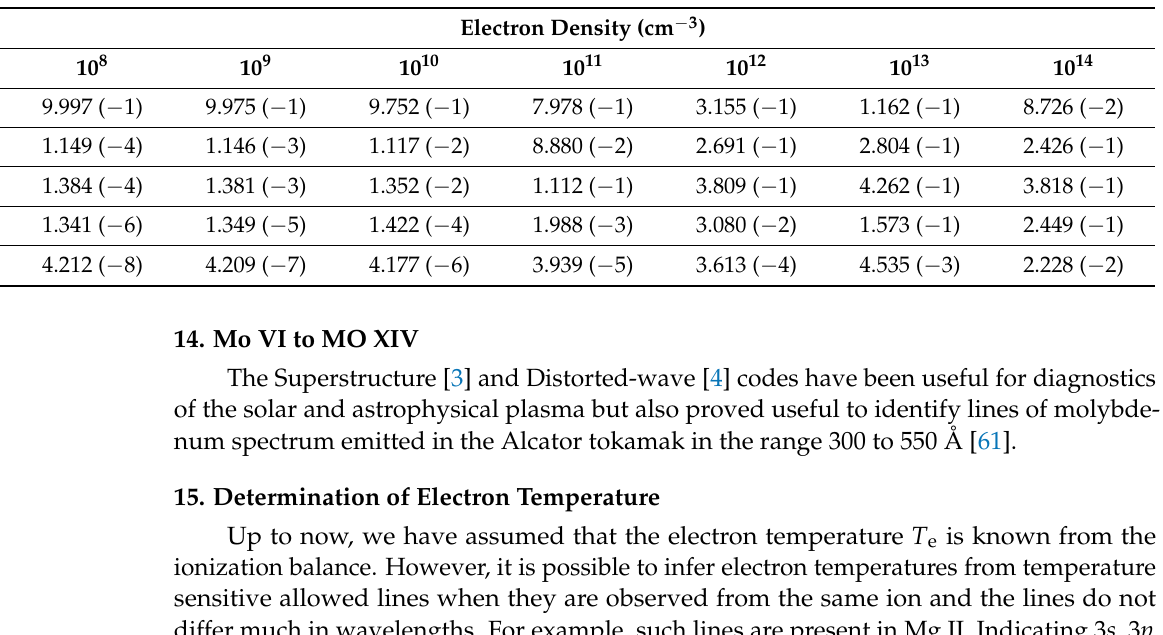
Table 17. Level populations in Ni